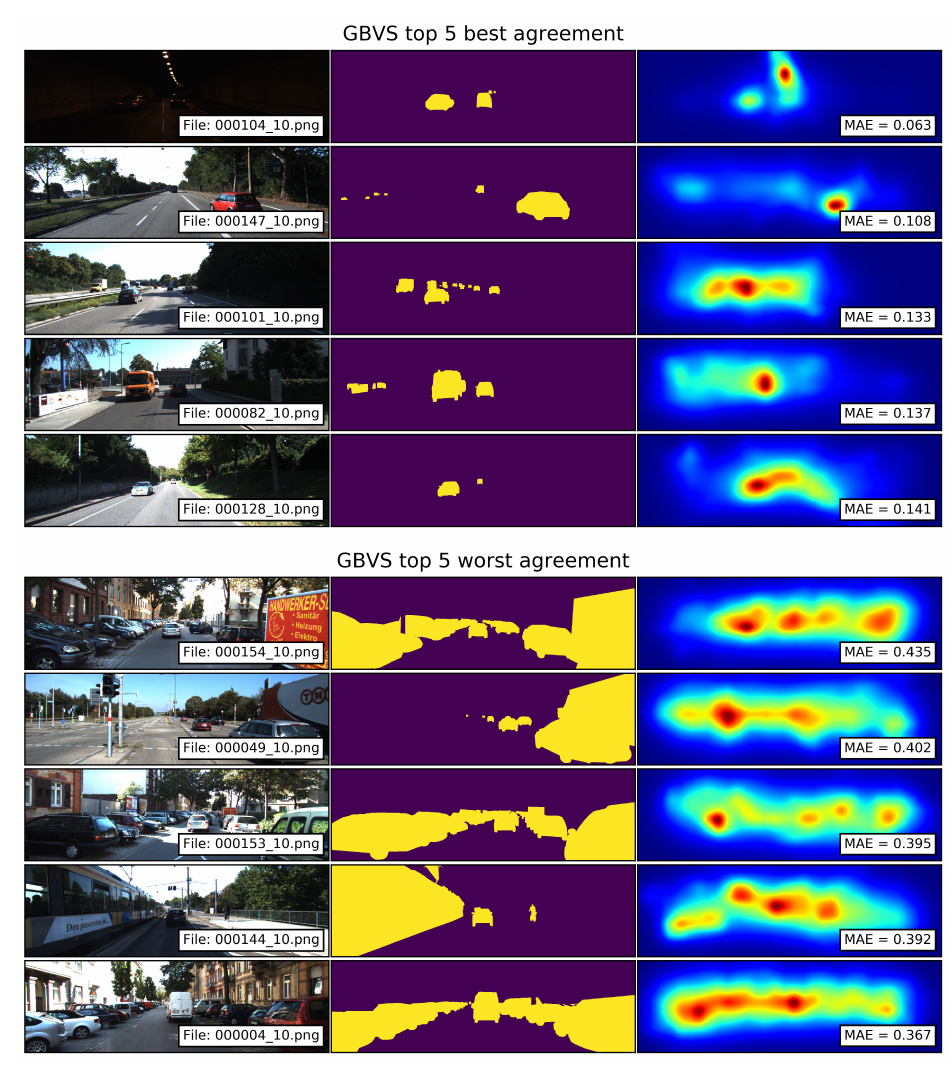
Figure 9. Top 5 best and worst agreements between the segments of traffic participants and the saliency maps computed with the GBVS model. Smaller MAE values correspond to a better